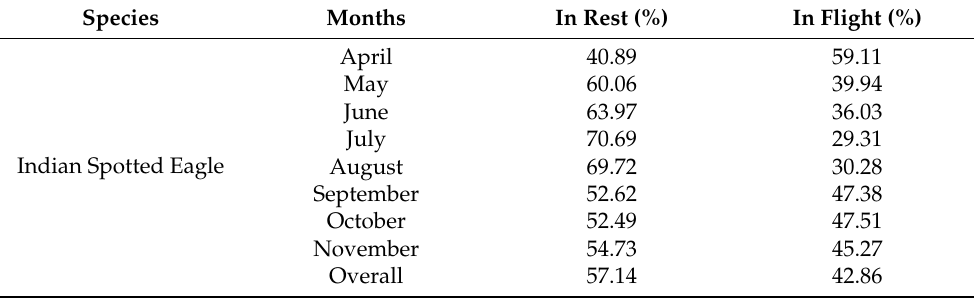
Table 5. Month-wise and the overall proportion of time spent in flight and in rest state. GPS fixes with an instantaneous speed of more than 1 km per hour were characterised as ‘in flight’ state and otherwise as ‘in rest’